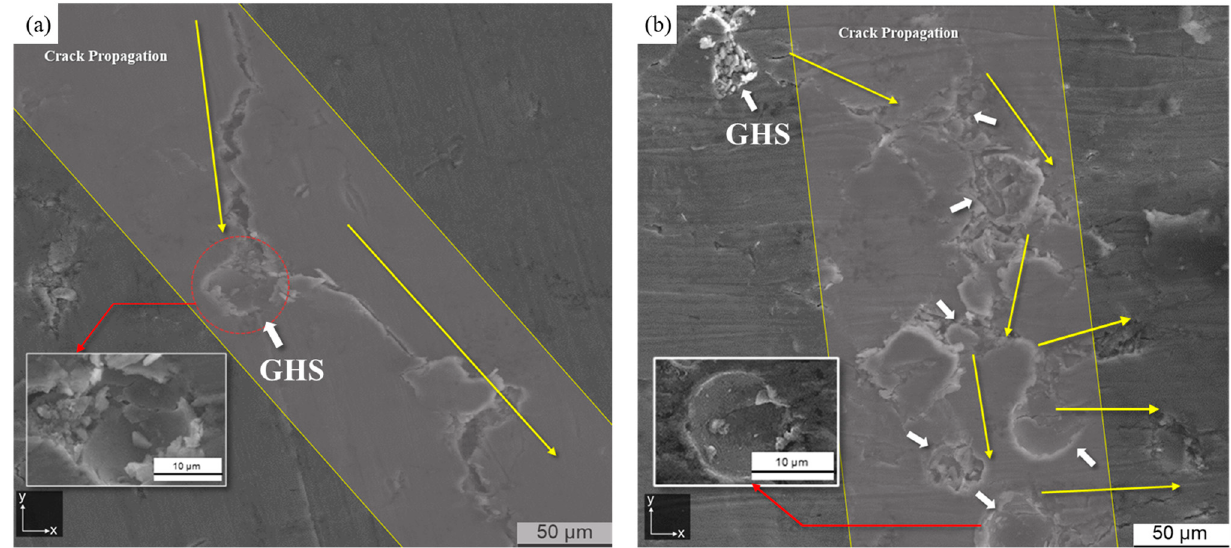
Figure 14. Crack propagation process; ( a ) Al60G5 and ( b ) Al60G10.